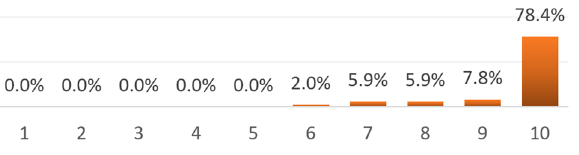
Figure 15. Do you recommend the presentation of the truss for future classroom activities as well as for free use? (1—do not recommend, 10—yes, strongly).